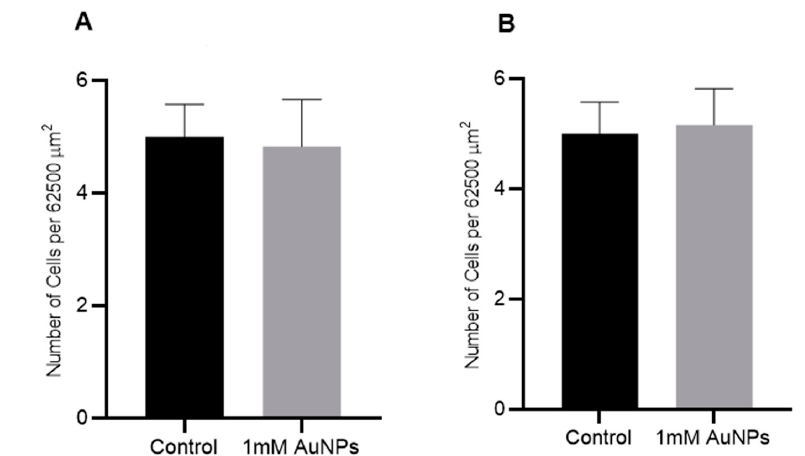
Figure 9. E ff ect of AuNPs on cell adhesion of human cancer cells in vitro. ( A ) DU145 (prostate) and ( B ) A549 (lung) cancer cells were treated with 1 mM AuNPs and after 24 h the cells were trypsinised and plated in 6 well plates. After 4 h, the number of adhered cells in a 62,500 µ m 2 area were counted. Results are expressed mean ± SEM of 3 replicates.